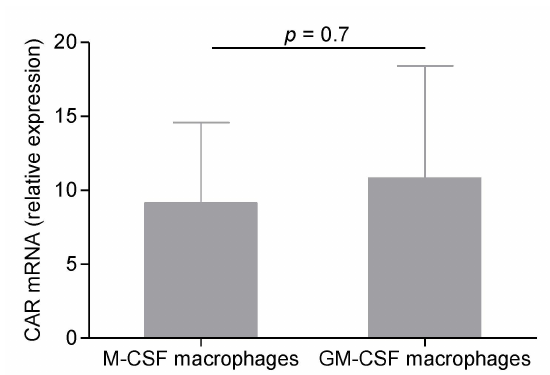
Figure 3. CAR mRNA expression in macrophages. Monocytes and MDM treated with M-CSF or GM-CSF for seven days were collected, and RNA was extracted. CAR mRNA and β -actin were amplified using real-time RT-PCR. CAR relative expression was determined using the 2 ´ ∆∆ Ct formula, as compared to parental monocytes. These results are the mean ˘ SEM of three independent experiments.